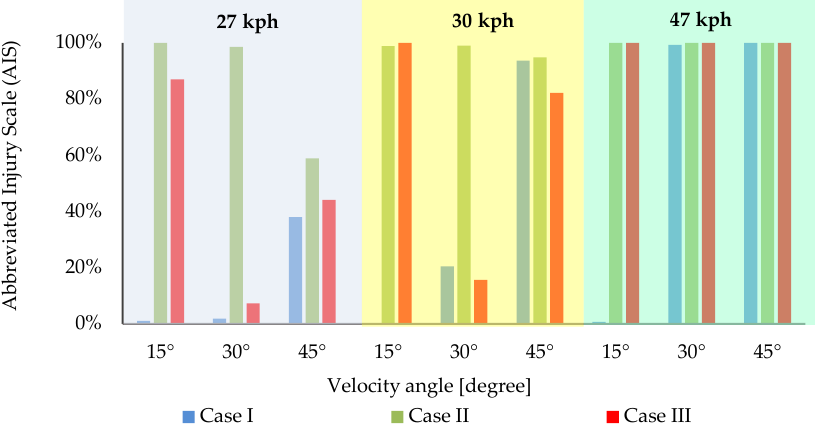
Figure 20. Probability of head injury according to AIS 2+.